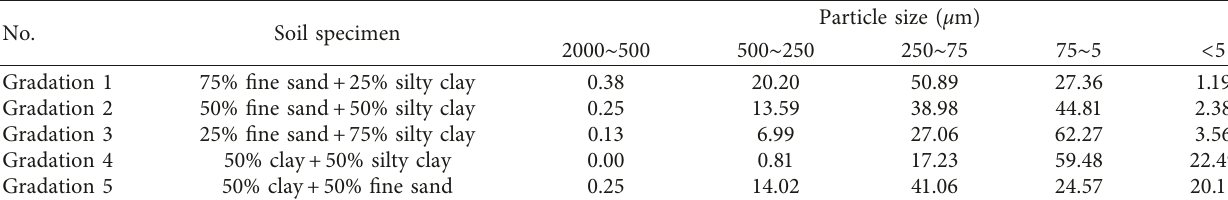
Figure 7: Test results of mixed-soil composition: (a) unconfined compressive strength; (b) permeability coefficient. Table 9: Percentage of different particle